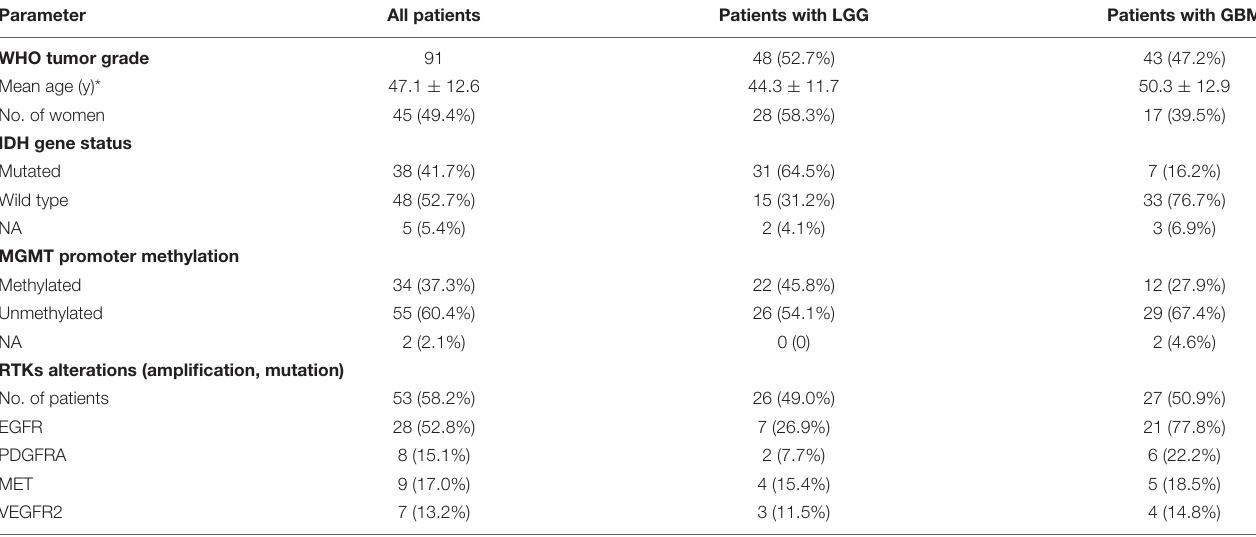
TABLE 1 | Patient demographics and genetic